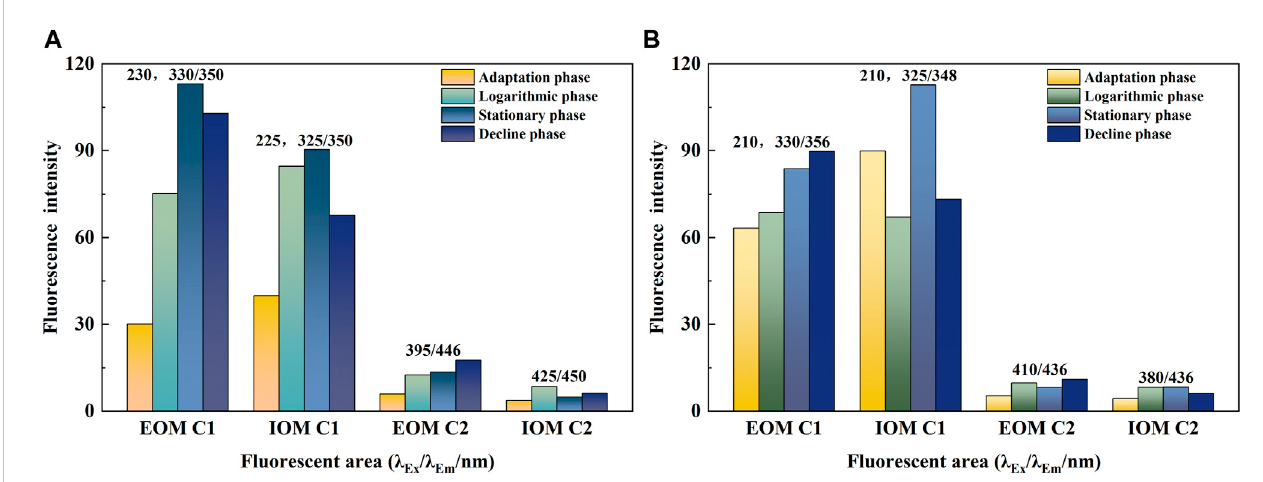
FIGURE 4 Fluorescence spectral characteristics of EOM and IOM of Chlorella vulgaris and Scenedesmus obliquus at different growth stages. (A) Chlorella vulgaris ; (B) Scenedesmus obliquus